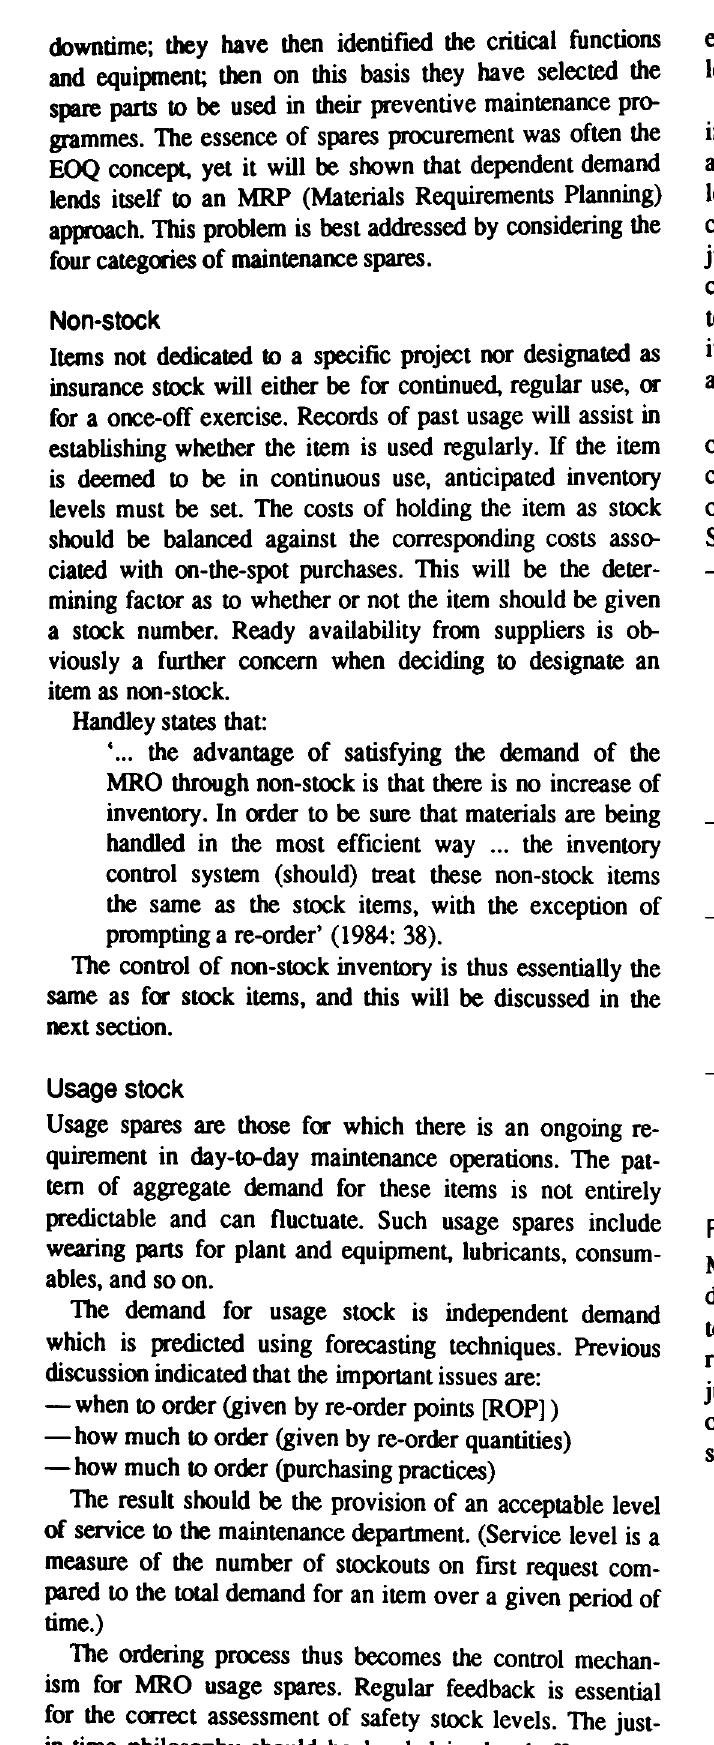
Schematic of preventive maintenance requirements